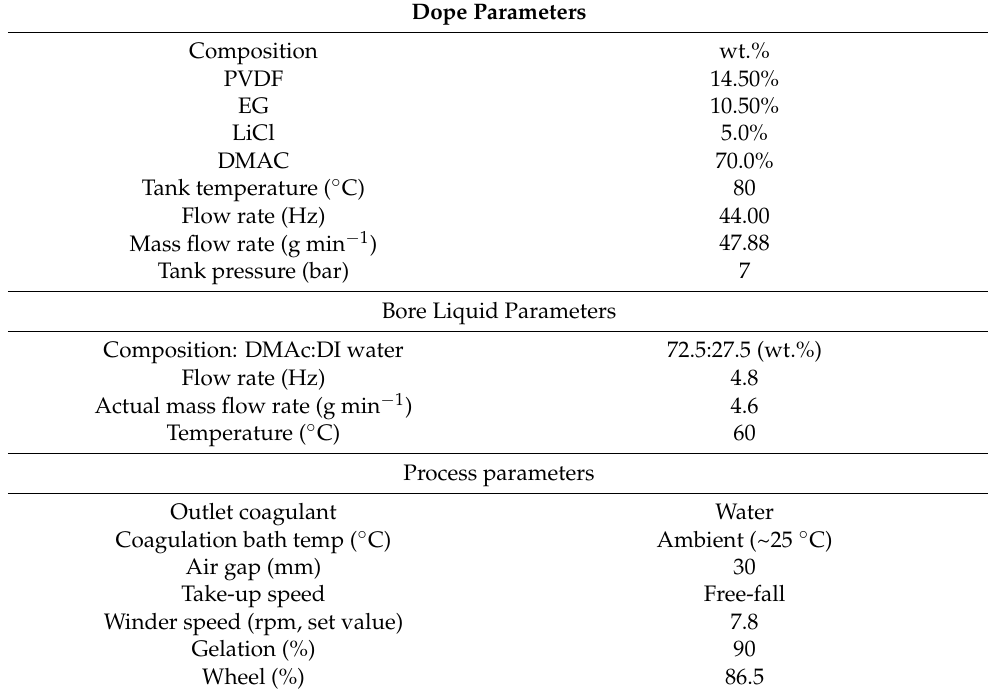
Table 1. Dope composition and spinning conditions for the PVDF tri-bore hollow fiber